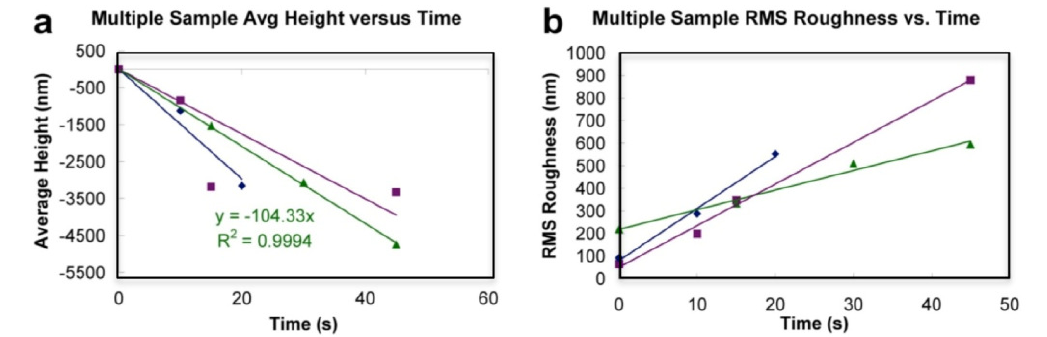
Figure 10. Dental enamel surface height and roughness as metrics to quantify mineral loss. ( a ) Variation in surface height between one minute and 30 minutes. ( b ) Variation in roughness between one minute and 30 minutes (from image size 1240 × 940 µ m). After about one minute the RMS roughness plateaus, as does the erosion rate. Data from several samples suggests erosion for less than one minute proceeding rapidly as pits are formed and the smooth enamel surface quickly roughens. Reprinted with permission from